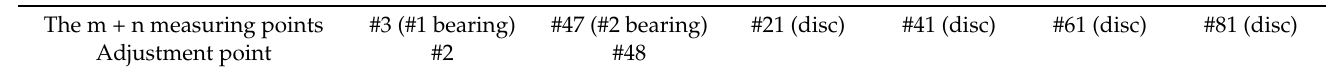
Table 8. The measuring points for h4.4.